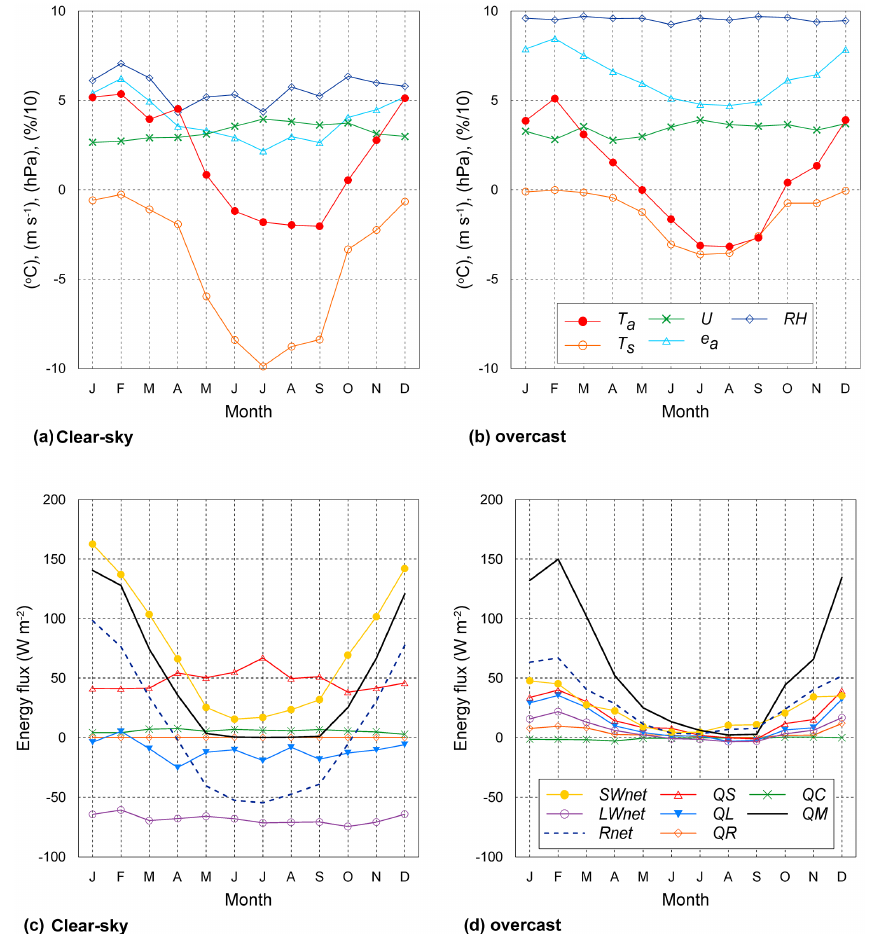
Figure 6. Monthly mean surface climate (a, b) and surface energy fluxes (c, d) at AWS glacier in (a, c) clear-sky and (b, d) overcast conditions. Partial cloud conditions are a graduation between the two extremes and are not shown for brevity. Surface climate variables include air and surface temperature ( T a and T s ; ◦ C), wind speed ( U ; ms − 1 ), vapour pressure ( e a ; hPa), and relative humidity (RH) on a scale from 0 to 10 (i.e. % / 10). Table 5. Mean differences in surface climate between clear-sky and overcast conditions. Positive values indicate an increase in overcast conditions.